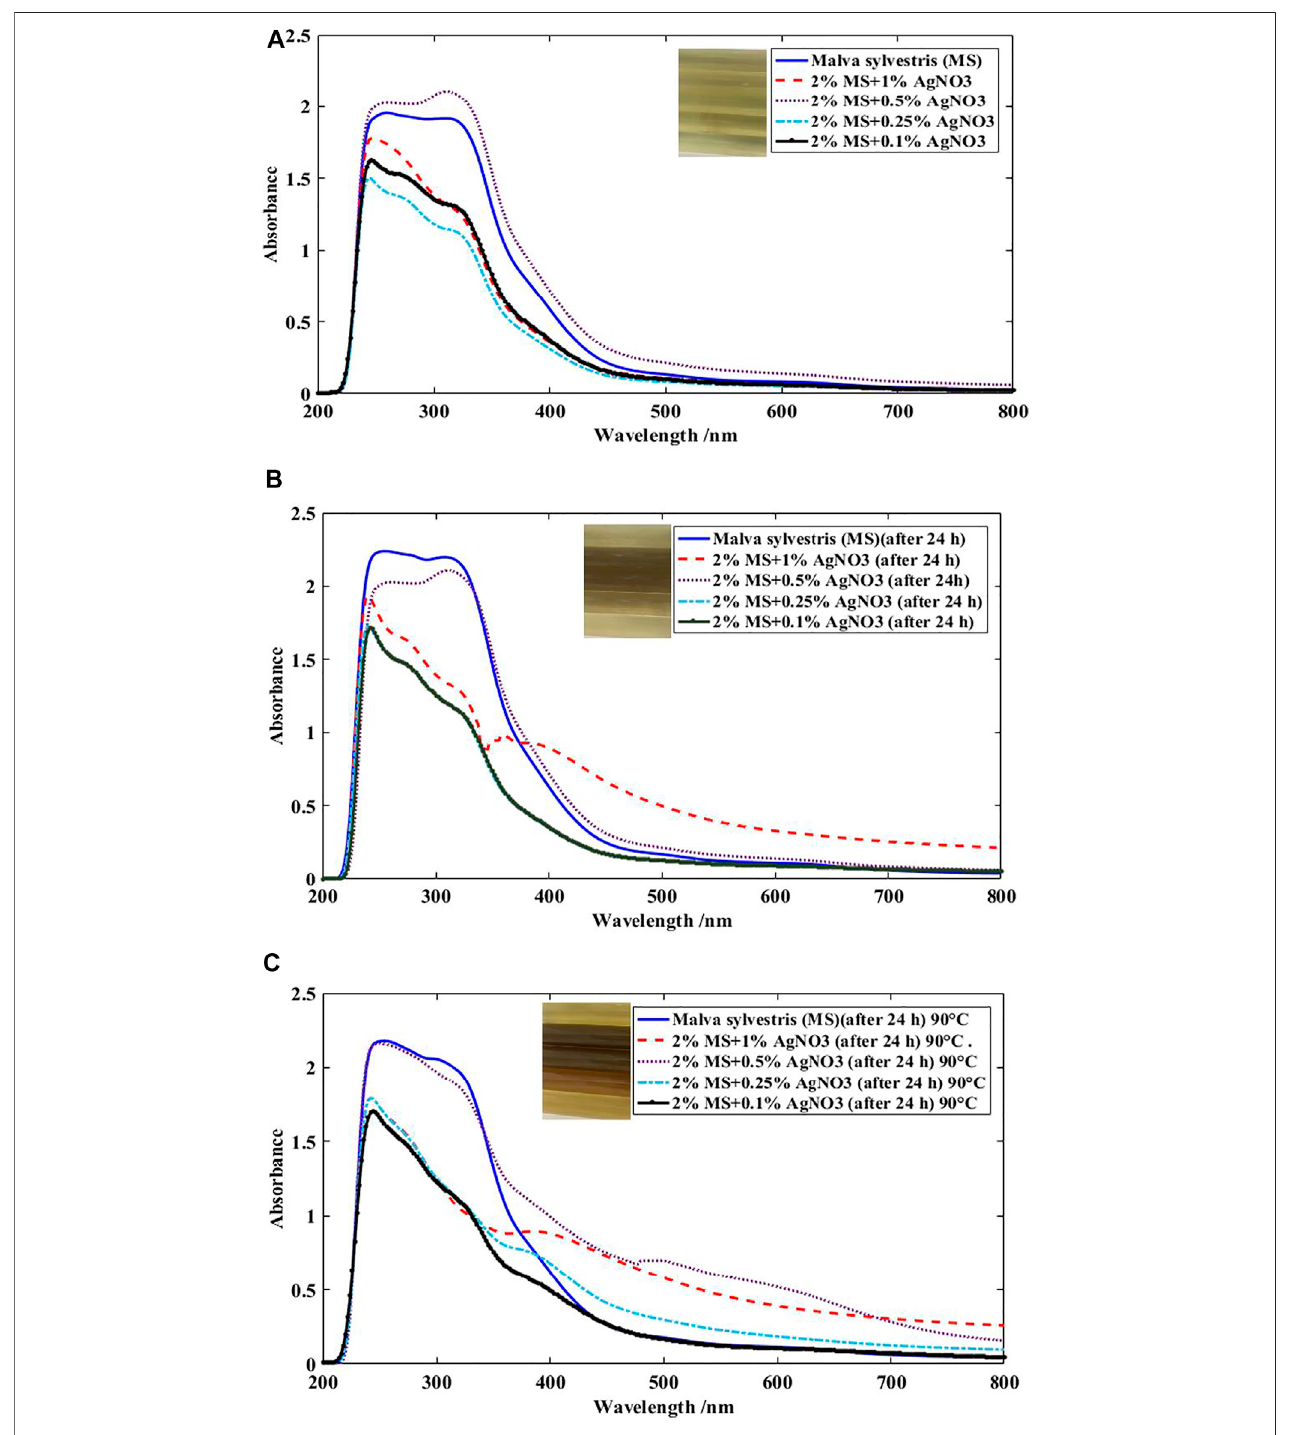
FIGURE 4 | UV-Visible spectra of 2% MS extract at various amounts of Ag (A) at room temperature after 2 – 3 min, (B) at ambient temperature after 24 h, (C) at ambient temperature after 24 h followed by heating at boiling for 1 h